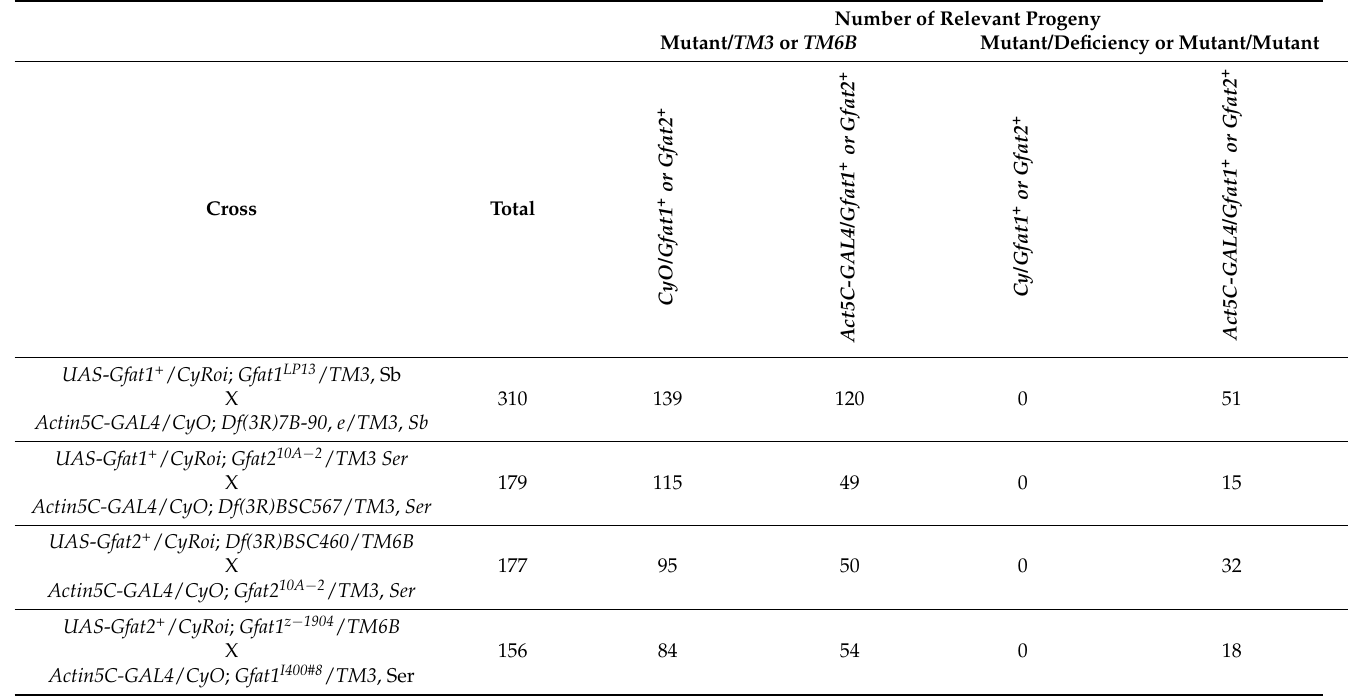
Figure 5. Transcript model of Gfat2 - RA . The approximate location of the P-element insert used for the excision experiment is shown above by an inverted triangle. The approximate end points for the excision deletions Gfat2 18A − 14 (498 bp in length) and Gfat2 10A − 2 (1038 bp in length) are shown above by arrows. Table 2. Mutant rescue with Gfat1 + and Gfat2 +